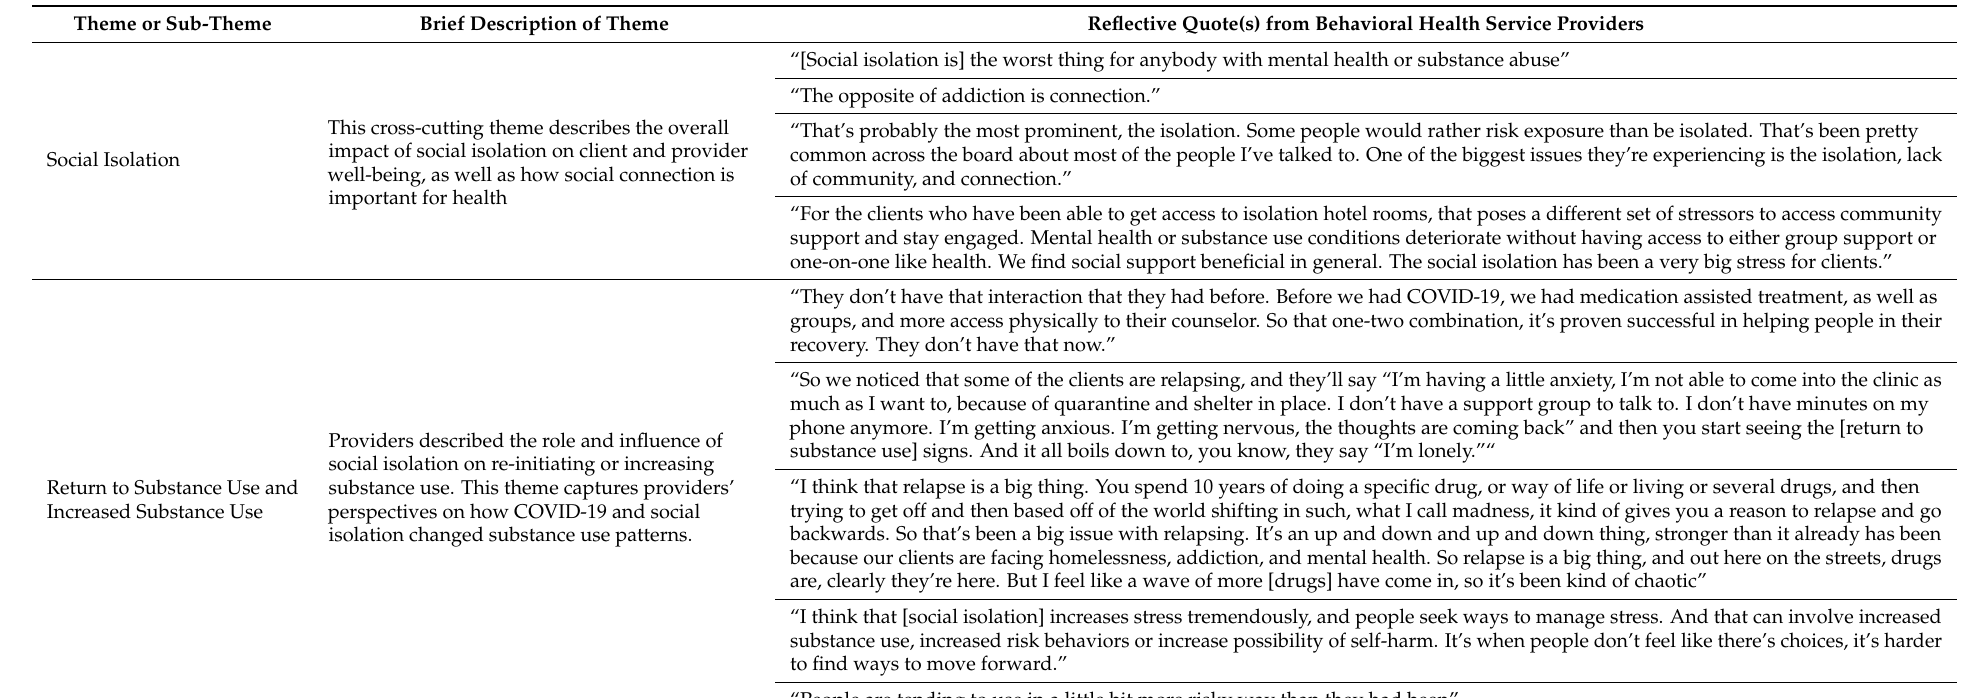
Table 2. Themes and Quotes from Behavioral Health Service Provider Interviews on Impact of Social Isolation during the COVID-19 Pandemic on Mental Health, Substance Use, and Homelessness, USA, 20 August–14 October